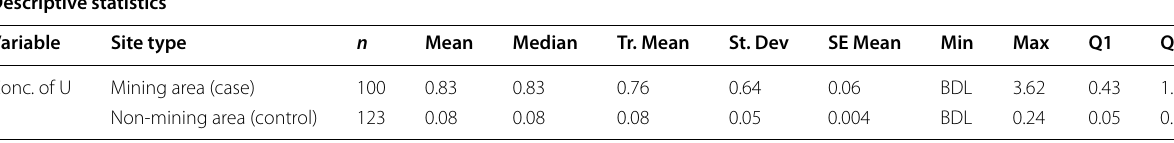
Non-mining area (control) Conc. Concentration in µg/L = Min, Max, Tr. Mean, St. Dev, SE Mean Q1 and Q3 stand for minimum, maximum, trimmed mean, standard deviation, standard error mean, lower quartile and the upper quartile, respectively BDL below detection limit of the ICP MS used in the analysis of the samples